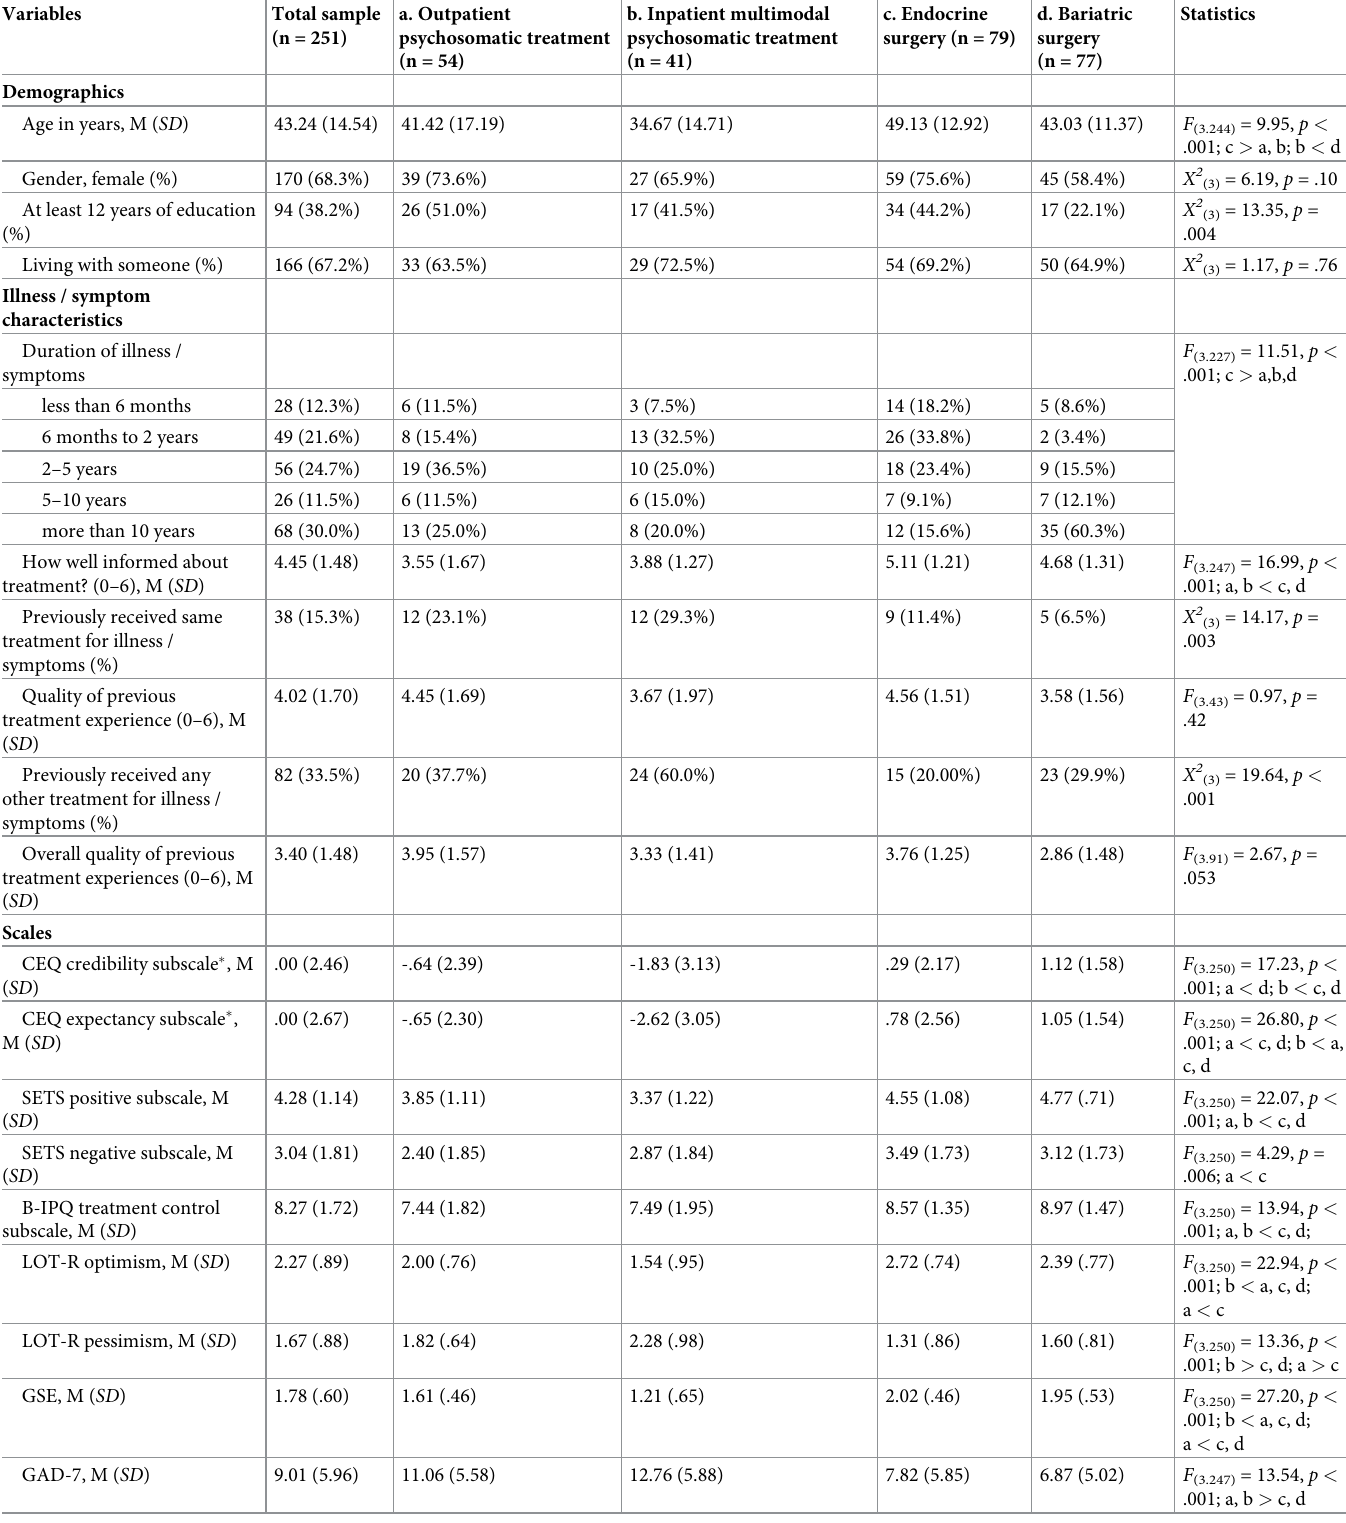
Table 1. Characteristics of the validation